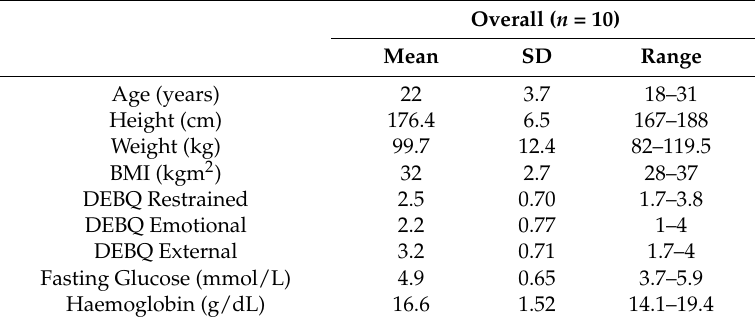
Table 1. Baseline participant characteristics in the screening ( n = 10); the data are shown as the mean values with standard